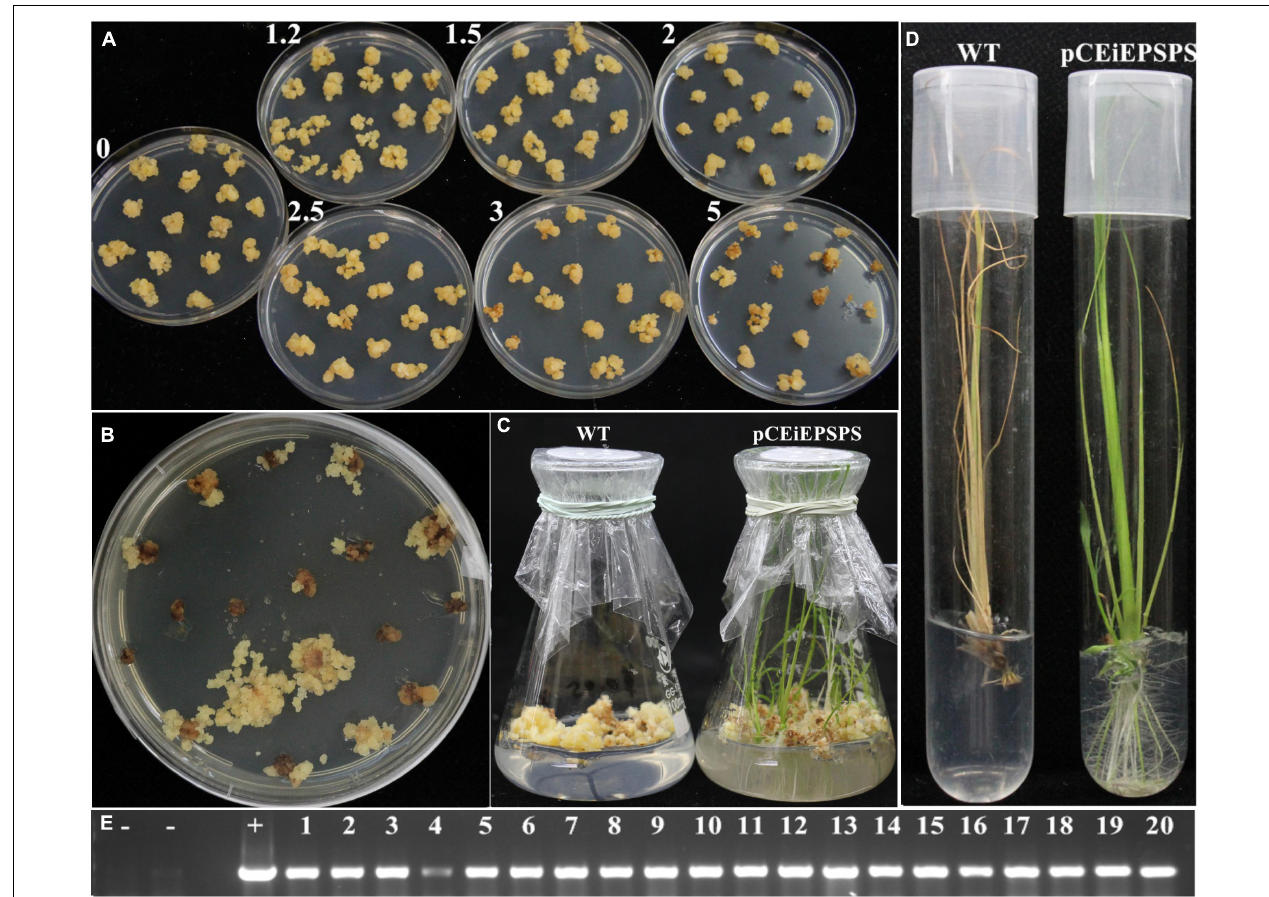
FIGURE 2 | Transformation using whole-step selection by glyphosate-based on pCEiEPSPS vector. (A) Glyphosate tolerance tests for the ZH11 callus. The numbers represent different glyphosate concentrations (mM) in the subculture medium. (B) Selection of positive callus on the selection medium containing 3 mM glyphosate after about 40 days of infection. (C) Thirty-five-day-old regenerated shoots under the 0.05 mM glyphosate pressure. Wild type (WT), ZH11 callus; pCEiEPSPS, positive callus from panel (B) . (D) Two-week-old rooting plantlets under the 0.05 mM glyphosate pressure. WT, ZH11 regenerating plantlets; pCEiEPSPS, positively regenerated plantlets from panel (C) . (E) The positive transgenic events were determined by PCR using the EiEPSPS specific primers (UEU-F1 and UEU-R1). Lane -, -, H 2 O, and ZH11 genomic DNA used as the negative control, respectively; Lane +, the vector pCEiEPSPS used as the positive control; Lane 1–20, independent pCEiEPSPS transgenic events. TABLE 1 | Agrobacterium -mediated transformation efficiency using the binary vector pCEiEPSPS and pCP4-EPSPS. Vector Selective agent Selection Regeneration Rooting efficiency Positive transgene Final transformation efficiency (%) efficiency (%) (%) events by PCR (%) efficiency (%) pCEiEPSPS 3 mM glyphosate 55 . 18 ± 7 .